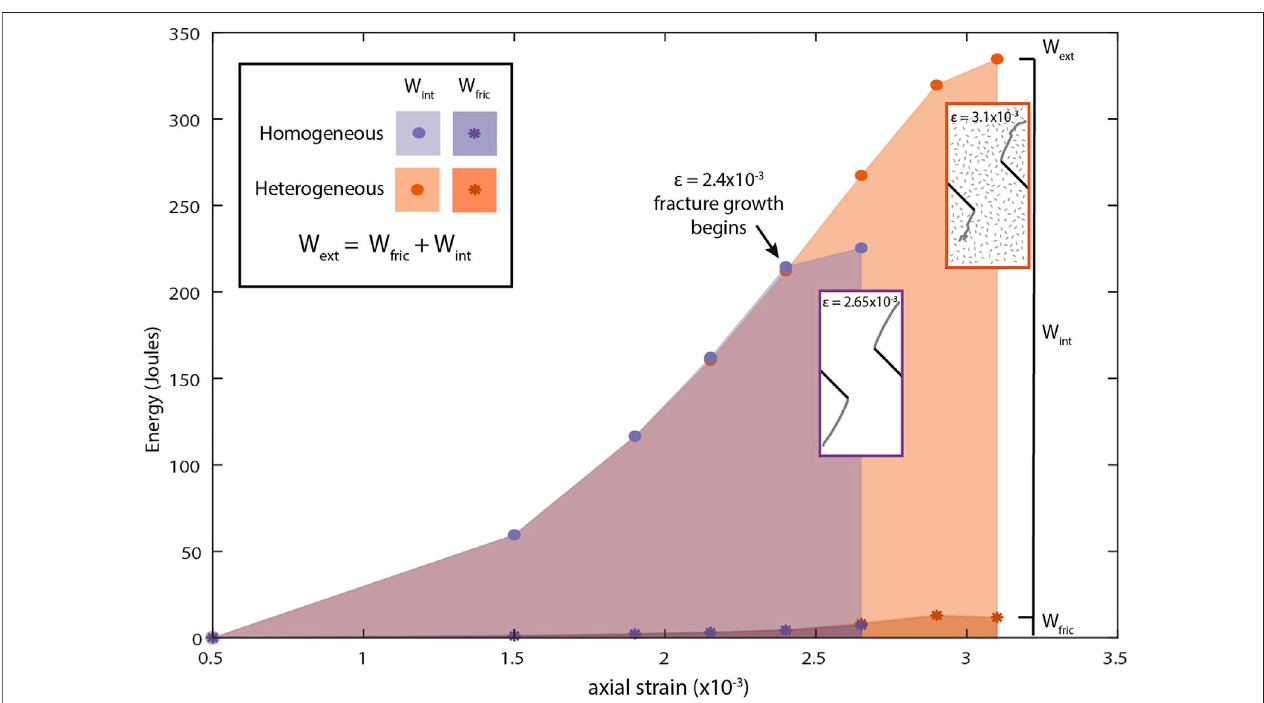
FIGURE10| Evolutionofenergybudgetwithincreasingaxialstrain.Theinternalwork(W int )andfrictionalwork(W fric )sumtotheexternalwork(W ext )ofthesystemat eachstrain.Stackedworkvaluesareshownforthehomogeneousmodelinpurple,andfortheheterogeneousmodelcontainingdistributed fl awsinorange,suchthatthe upper points are the total W ext , the lower points are the W fric , and W int is the vertical difference between the two points. Values are derived from homogeneous and heterogeneous (i.e., with microcracks) that have the same prescribed intact rock strength. Failure occurs at a lower strain for the homogeneous model.